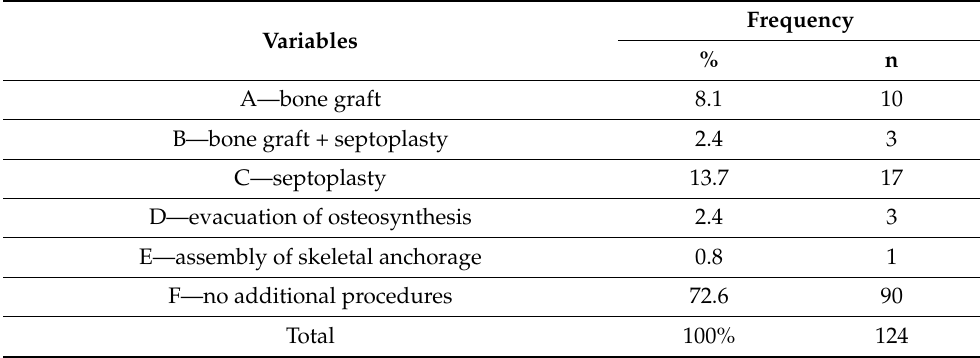
Table 8. Distribution of adjunctive procedures performed during surgery in the study group of patients.